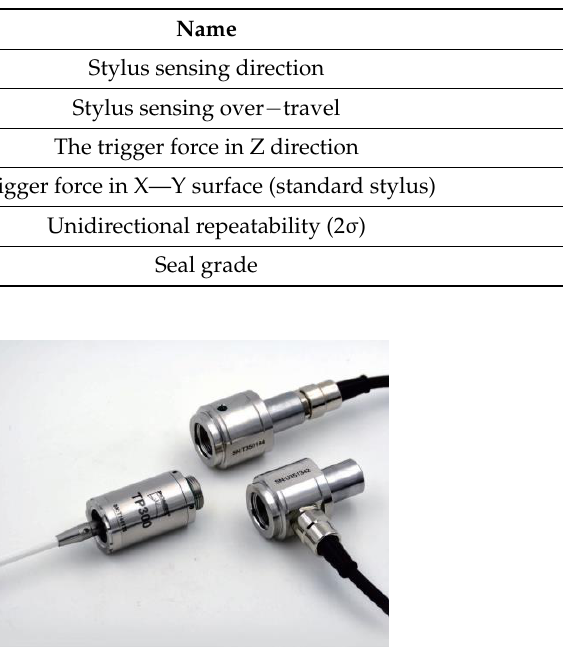
Figure 3. PIONEER TP300 series of cable probe.